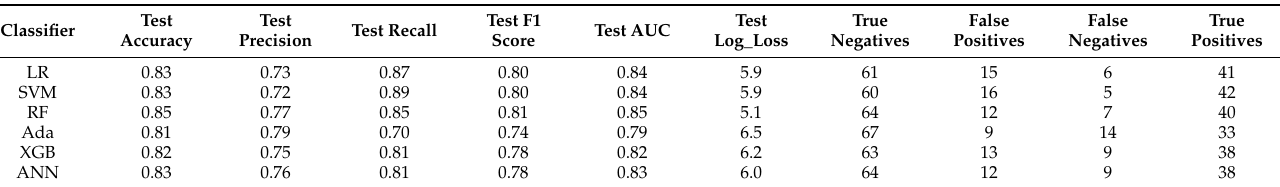
Table 9. Model performance metrics on unseen (test) data.